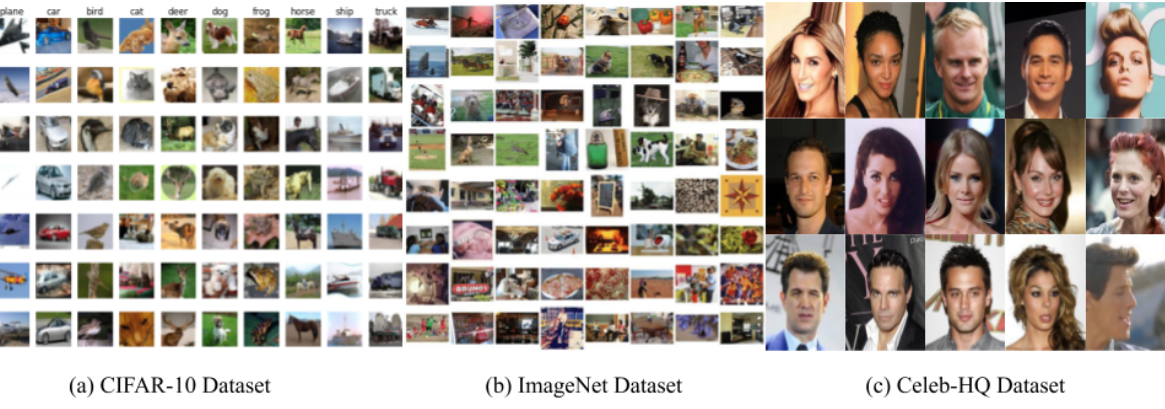
Figure 4. The examples from the CIFAR dataset ( a ), ImageNet dataset ( b ) and Celeb-HQ dataset ( c ). Network Configurations: In the CIFAR experiment, the depth of flow K and the number of levels L are set to 32 and 3, respectively. Meanwhile, the depth of flow in Ima- geNet experiments is set to 48, the numbers of levels of ImageNet 32 × 32 and ImageNet 64 × 64 experiments are set to 3 and 4, respectively. We use the Adam optimizer [47] to op- timize the networks in which batch size and learning rate are set to 64 (per GPU) and 0.001, respectively. We choose Normal Distribution as the prior distribution p Z ( z ) ∼ N ( z ; 0, I ) in all